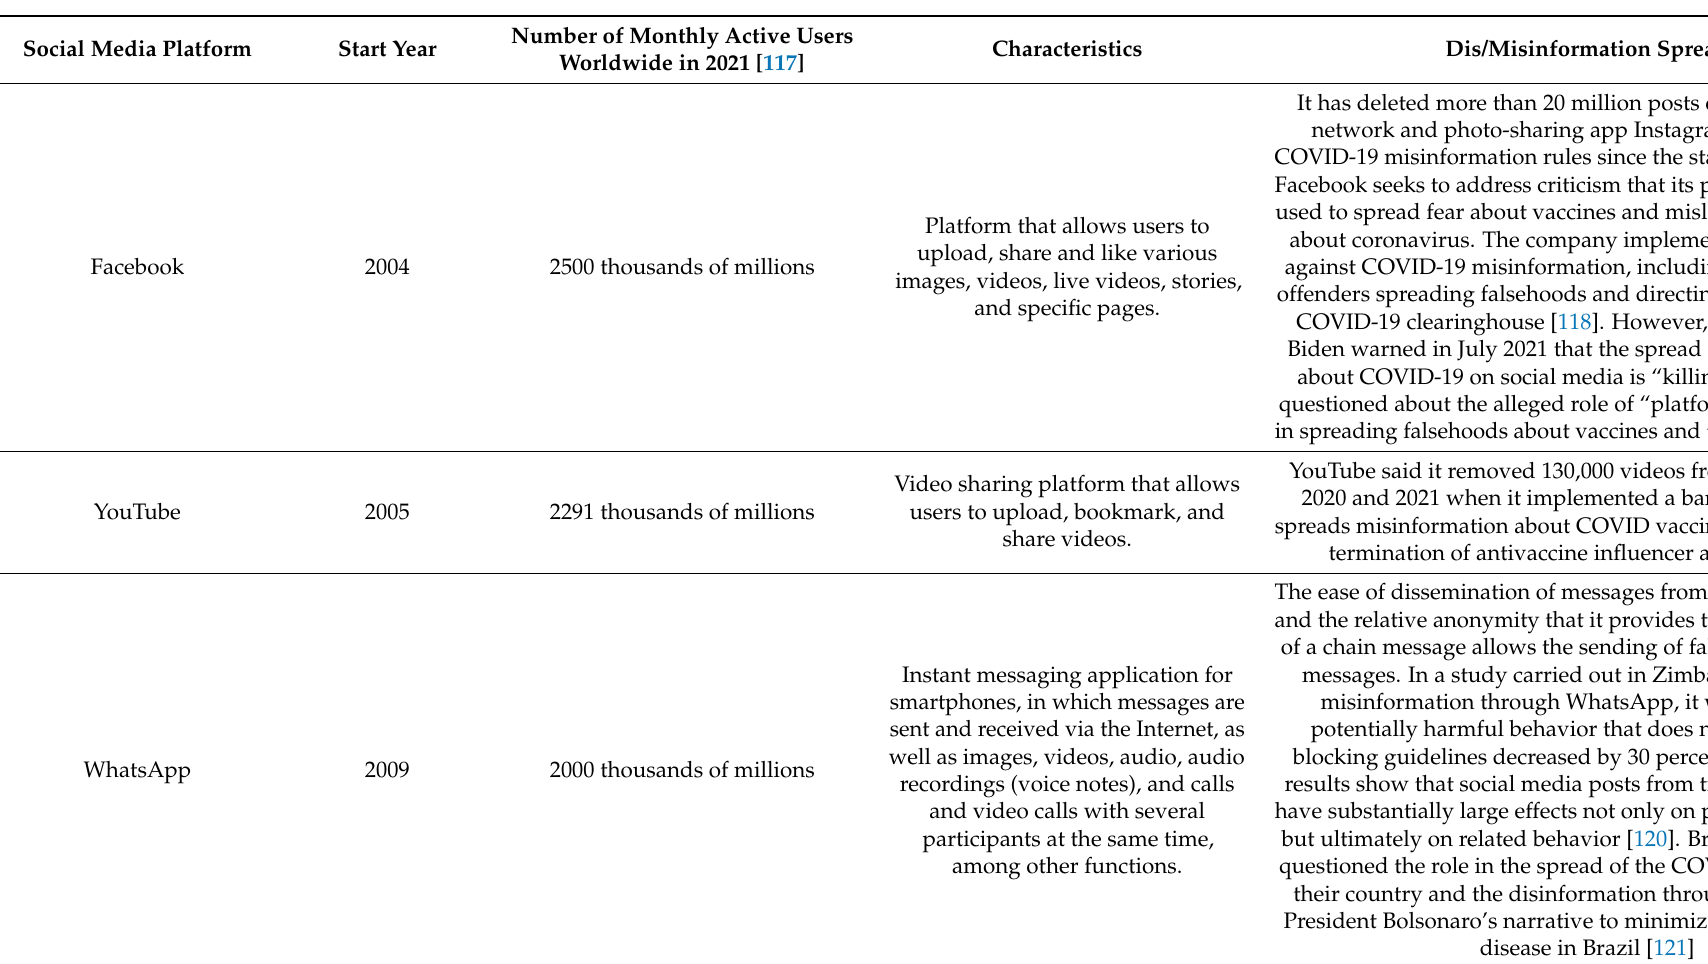
Table 1. Social media platforms and their